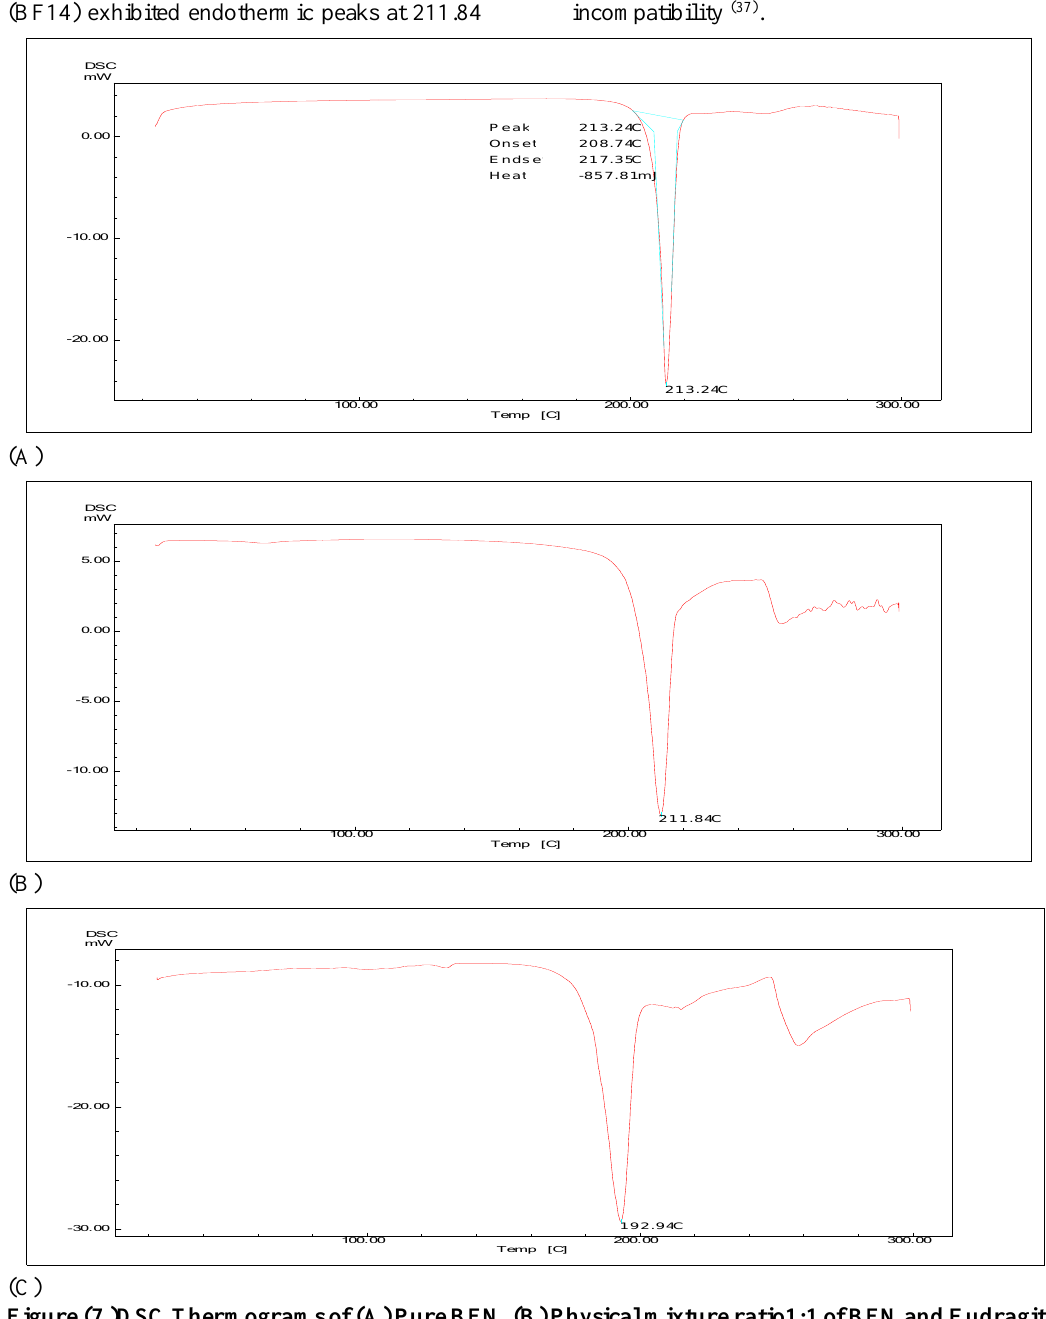
Figure (7 )DSC Thermograms of (A) Pure BFN, (B) Physical mixture ratio1:1 of BFN and Eudragit RS100, (C) BF